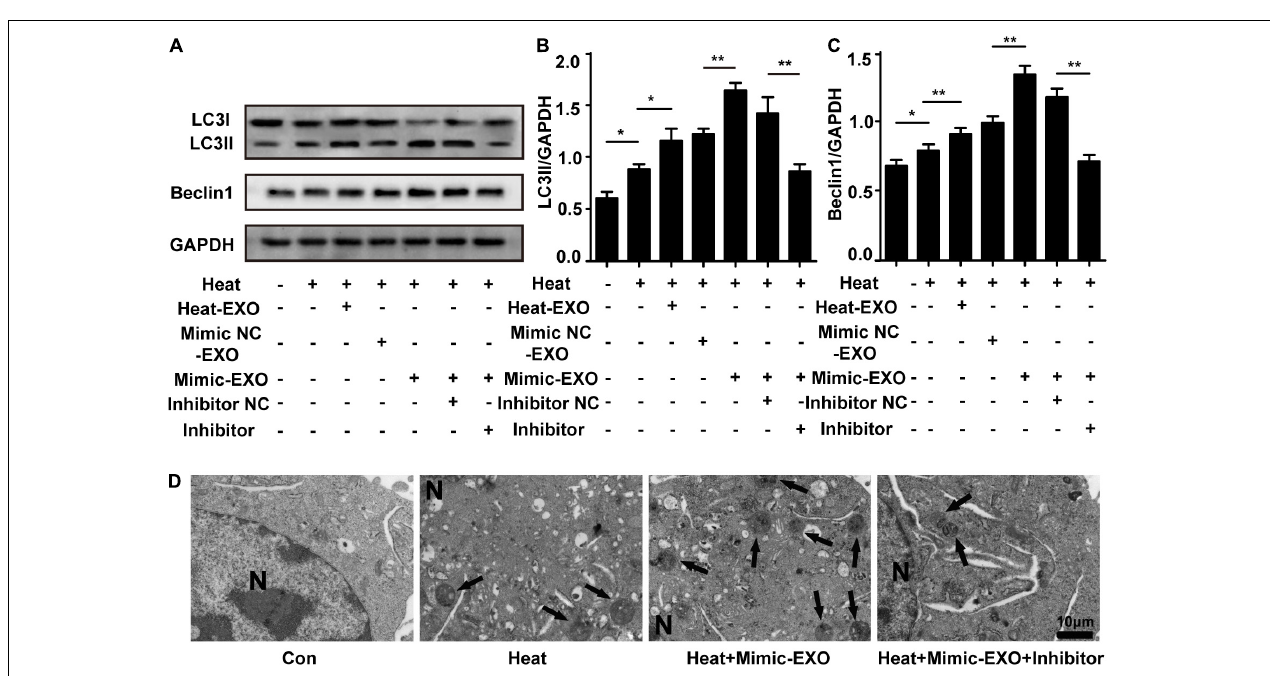
FIGURE 5 | miR-155 plays a critical role in the regulation of heat stress-induced neuronal autophagy by microglial exosomes. N2a cells were pretreated with or without miR-155 inhibitor or its negative control and then incubated with exosomes (50 µ g/ml) derived from BV-2 cells that were subjected to heat stress, miR-155 mimic, or miR-155 mimic negative control transfection. Finally, the cells were subjected to heat stress at 42 ◦ C for 2 h, followed by a 6 h recovery period at 37 ◦ C. (A–C) The protein expression of LC3 and Beclin-1 in N2a cells was determined by Western blotting. Densitometric analysis was performed. (D) Autophagosomes in the cytoplasm of N2a cells were observed by TEM. Representative images are shown. All the data are presented as the means ± SDs of at least three independent experiments. * p < 0.05; ** p <